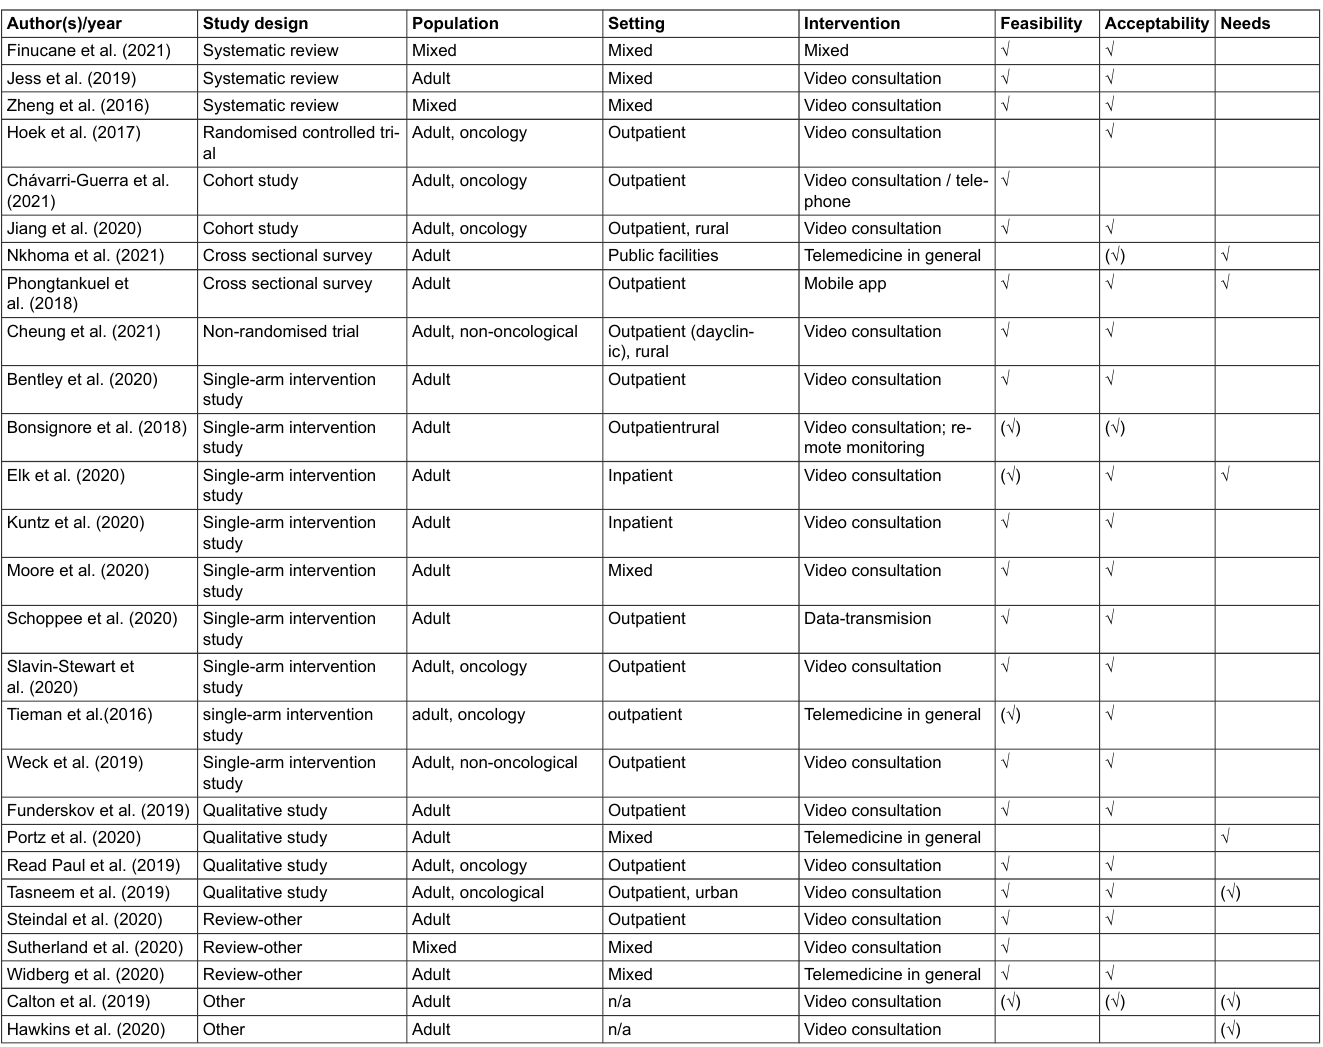
Table 1: Characteristics of the sources of evidence in the included studies/reports (summary).